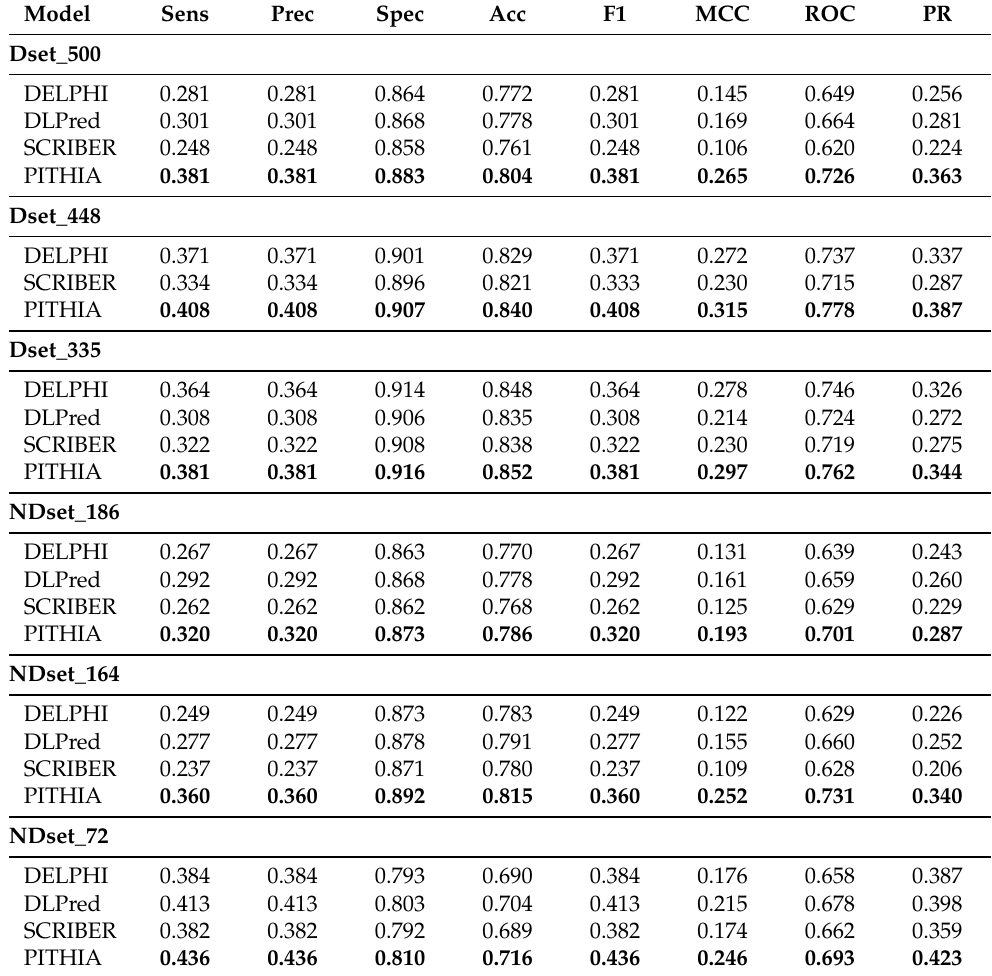
Table 1. Performance comparison with the state-of-the-art models SCRIBER, DLPred and DELPHI on datasets Dset_500, Dset_448, Dset_355, NDset_186, NDset_164, and NDset_72. The best results are shown in boldface.